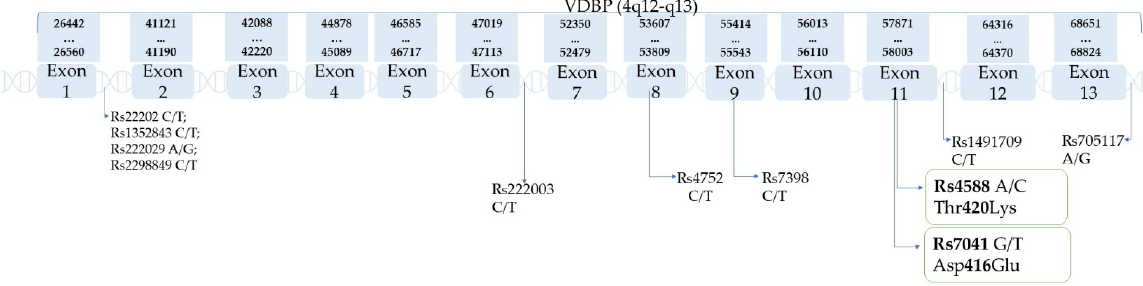
Figure 2. VDBP gene and its polymorphisms (based on the SNPedia database [21]). Vitamin D binding protein was initially named the ‘group-specific component’ (Gc) by Hirschfield in 1959 after isolation from the α 2-globulin portion of plasma [33]. As a result of the binding and transport of vitamin D analogs, the DBP name was adopted. After discovering macrophage-stimulating activities, VDBP was renamed as the macrophage- activating factor (GcMAF/DBP-MAF) [34]. The name has been changed several times,